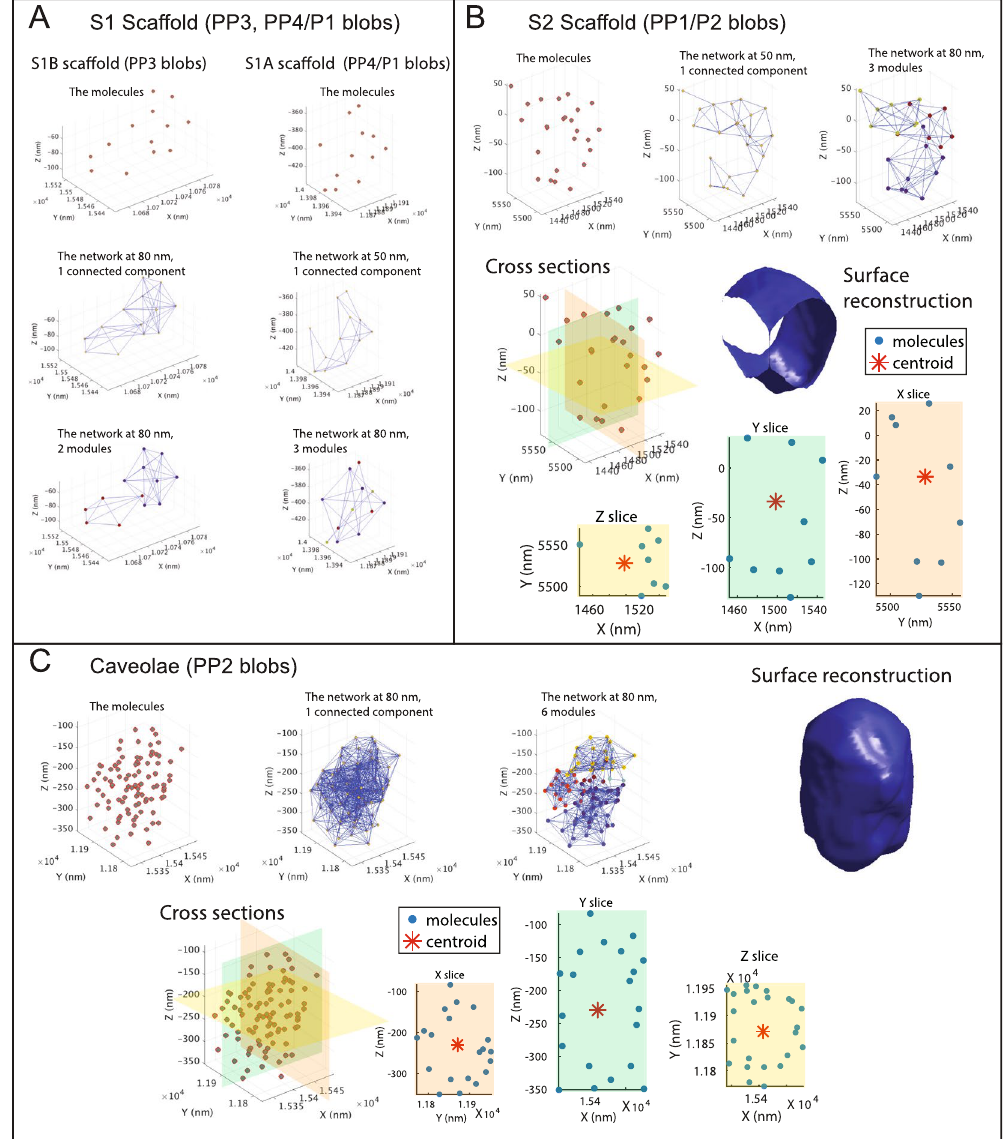
Figure 6. Visualization of representative blobs from PC3/PC3-PTRF cells. Blob’s molecules and networks (including number of connected components and modules) at various thresholds are shown for: ( A ) S1 scaffolds (PP3/PP4 blobs); ( B ) S2 Scaffolds (PP1 blob); and ( C ) Caveolae (PP2 blob). Cross-sections, XYZ slices and surface reconstructions are shown for S2 scaffolds and caveolae. Slice thickness for S2 scaffolds is 20% of the whole range of the blob size in each dimension and for caveolae 10%. S2 scaffolds are hemi-spherical and consist of 3-4 modules. Caveolae are spherical and hollow and consist of 5-6